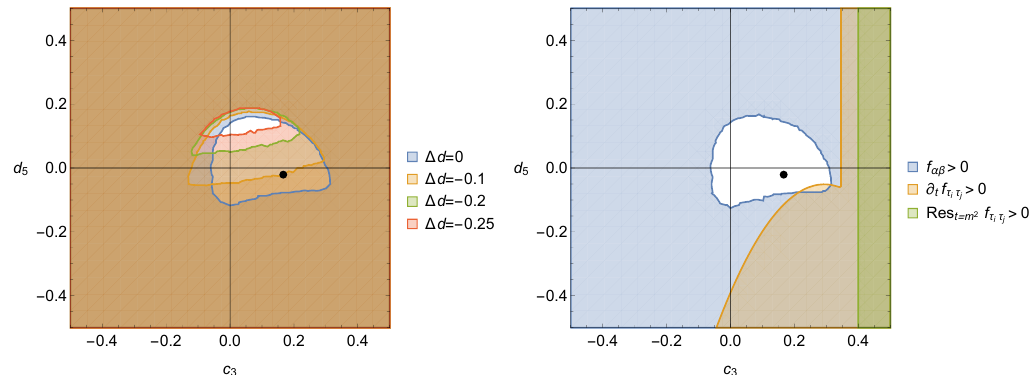
Figure 2 . Parameter space of massive gravity constrained by analyticity. The forward limit bounds on (cid:3) 5 massive gravity (left) gradually constricts as (cid:1) d is made more negative. However, going beyond the forward limit (6.34) rules out (cid:1) d 6 = 0 completely. In (cid:3) 3 massive gravity (right), the higher t derivative bounds marginally restrict the forward limit bounds. This lends further evidence to the idea that (cid:3) 3 massive gravity may admit a Wilsonian UV completion within this narrow